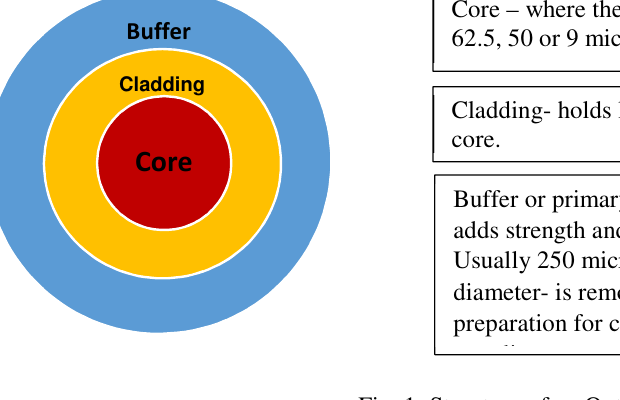
Fig. 1: Structure of an Optical Fiber